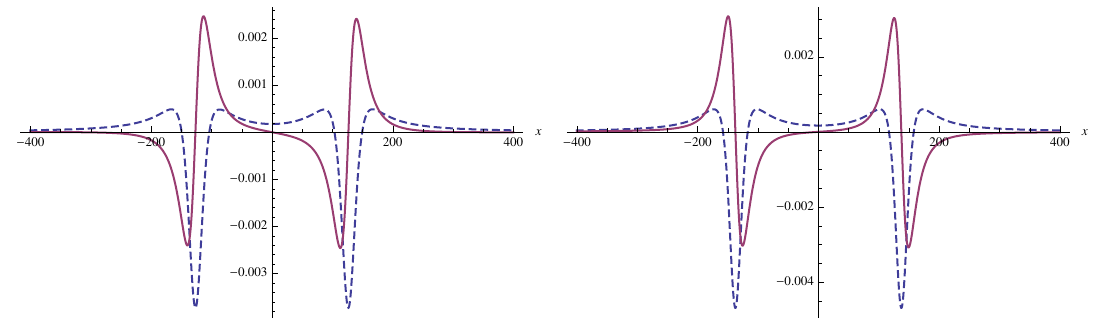
Figure 1 . Real (shown by dashed lines) and imaginary (shown by continuous lines) parts of potential (2.33) as a complex -symmetric stationary ( t = 0) solution to eq. (2.31) at α = 50 and PT ν = 25 (on the left) and α = 100, ν = 4 (on the right). The graph of imaginary part undergoes − − a flip as the parameter ν passes through a critical value 8. −